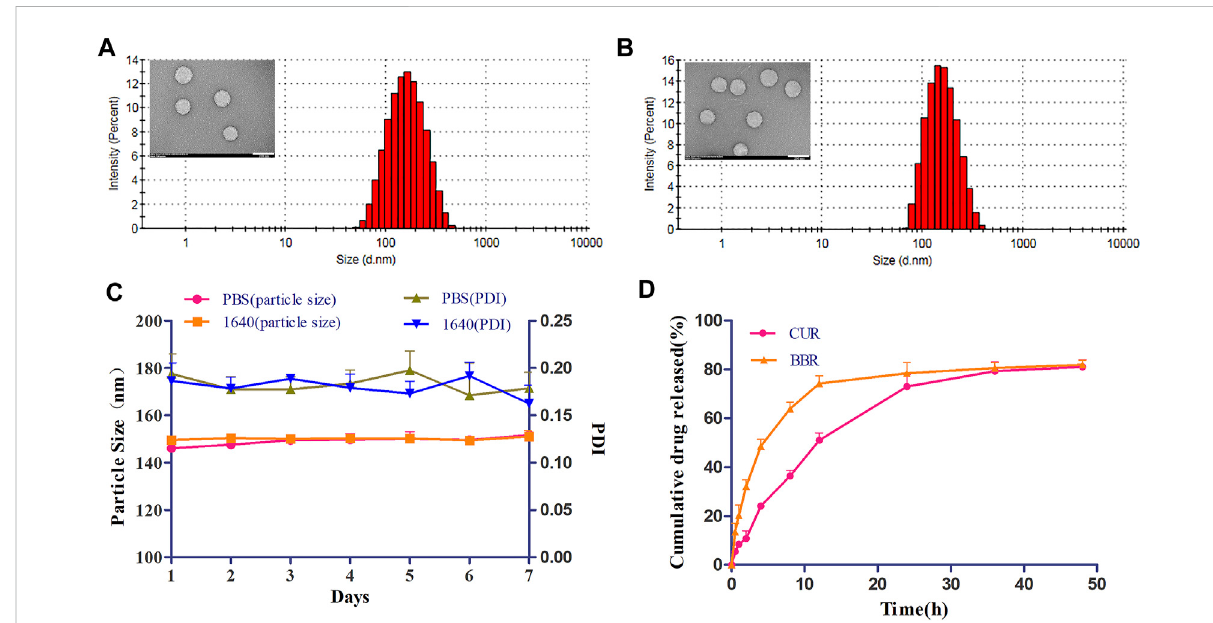
FIGURE 2 Physicochemical characterization of CUR&BBR/GA-HA-Lip. Particle size and TEM images of blank liposome (A) and CUR&BBR/GA-HA-Lip (B) . Scalebar,200 nm. (C) StabilityofCUR&BBR/GA-HA-Lipwithin7 daysbymonitoringtheparticlesizeandPDI. (D) Drugreleasepro fi lesofCUR&BBR/